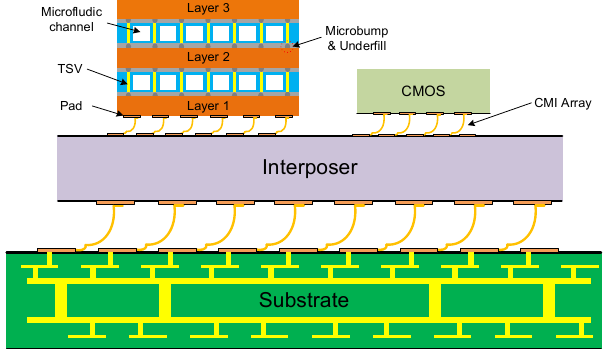
Figure 1. Schematic of an integrated micro-system with CMIs.